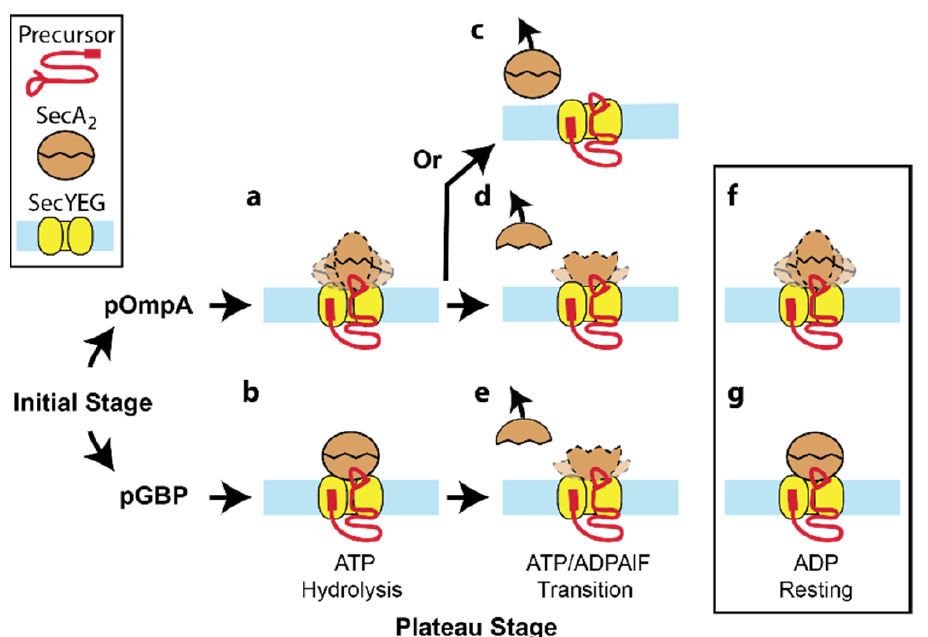
Figure 11. Model of precursor-dependent translocation. A summary of results is presented in cartoon form for pOmpA ( a , c , d , f ) or for pGBP ( b , e , g ) under the conditions listed. Individual components of the system include the following: precursor (red) with an N-terminal signal sequence and a disulfide-stabilized loop, SecA 2 (brown), and SecYEG (yellow) in a lipid bilayer (light blue). The dashed lines indicate distinct stable conformations apparent on the time scale of AFM imaging. AFM measurements of the active Sec translocase do not provide direct visualization of SecYEG or the oligomeric state of SecYEG because it is buried underneath SecA. In the absence of this information, the monomer SecYEG is drawn in all conditions. In addition, cartoons are not meant to accurately convey the orientation of SecA or SecA 2 .